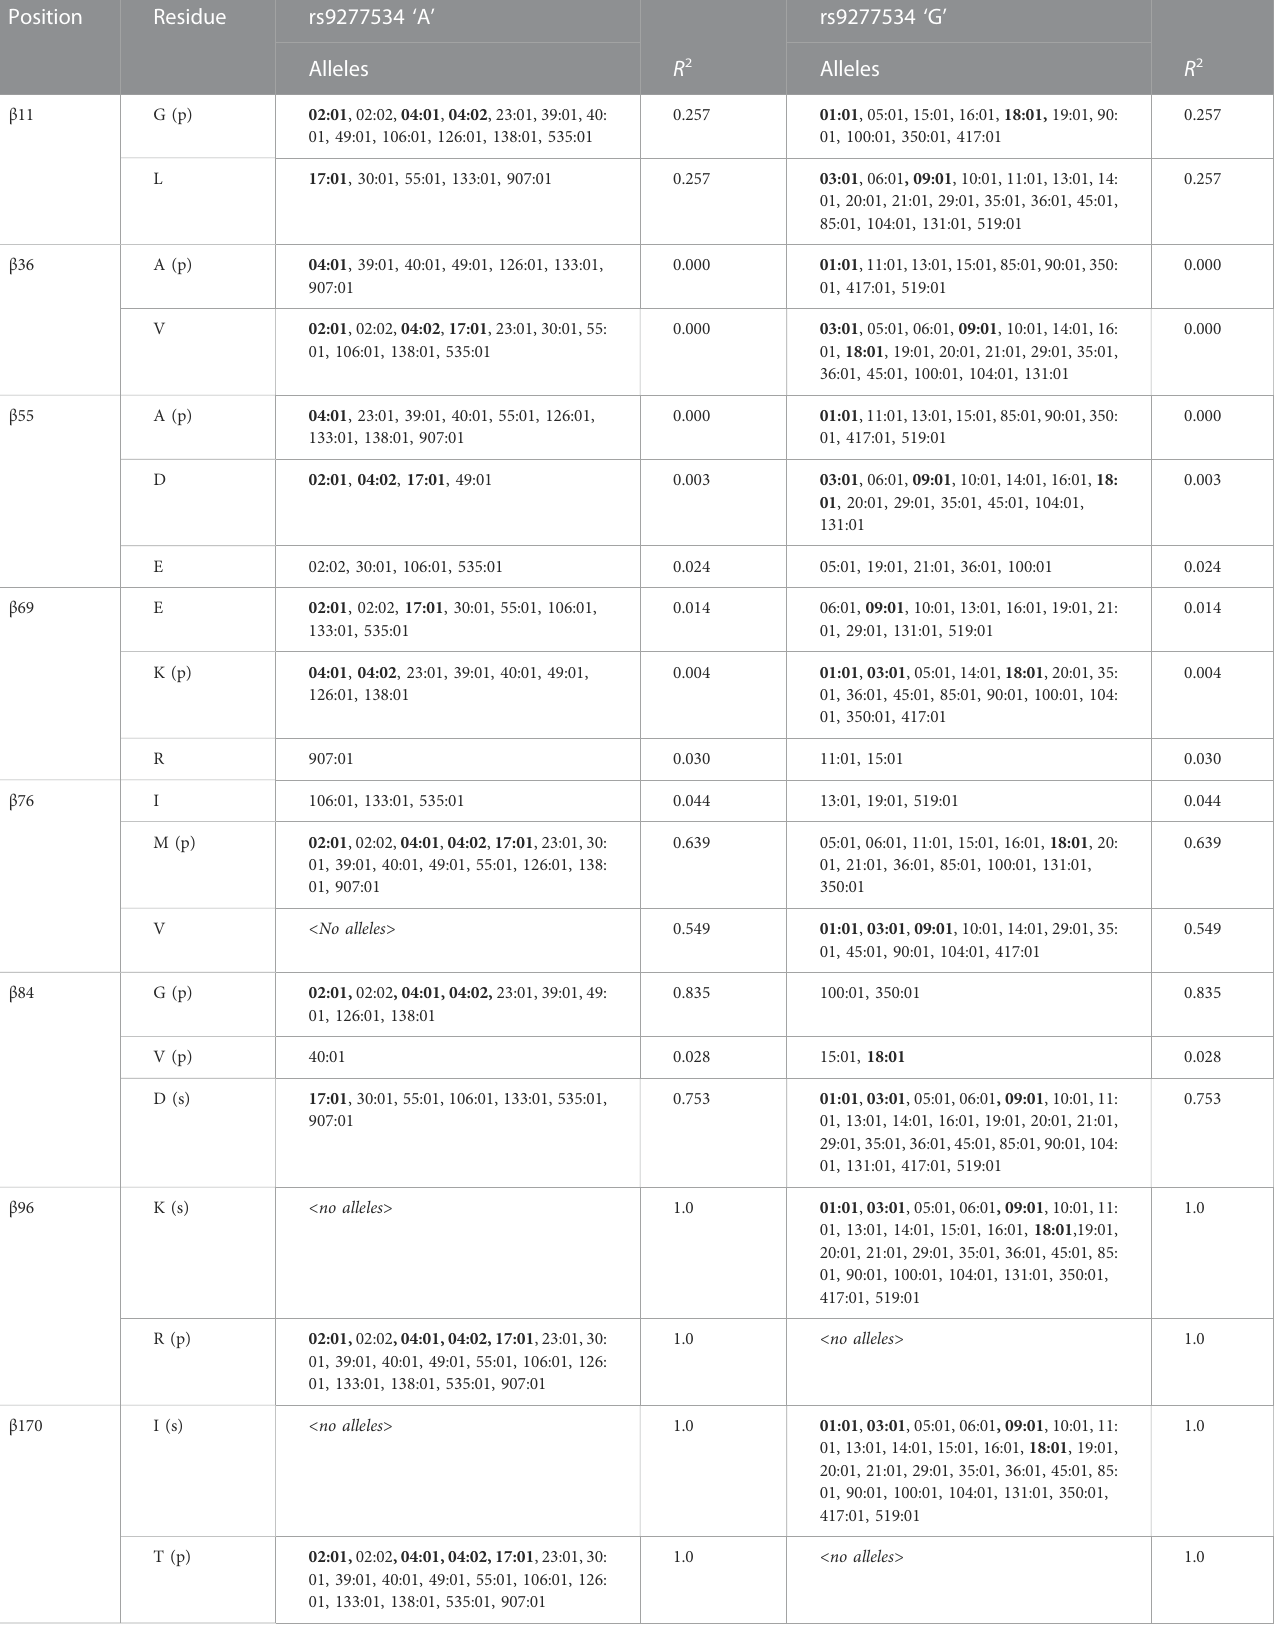
TABLE 7 Relationship between DPB1 positions with at least one residue of signi fi cance for protection/association of AD (Table 5; Supplemental Table 2) with DPB1 alleles found in this study and the 3 ’ UTR SNP rs9277534. Alleles with frequency > 0.05 are bold and underlined. (p) = protection; (s) = susceptibility.